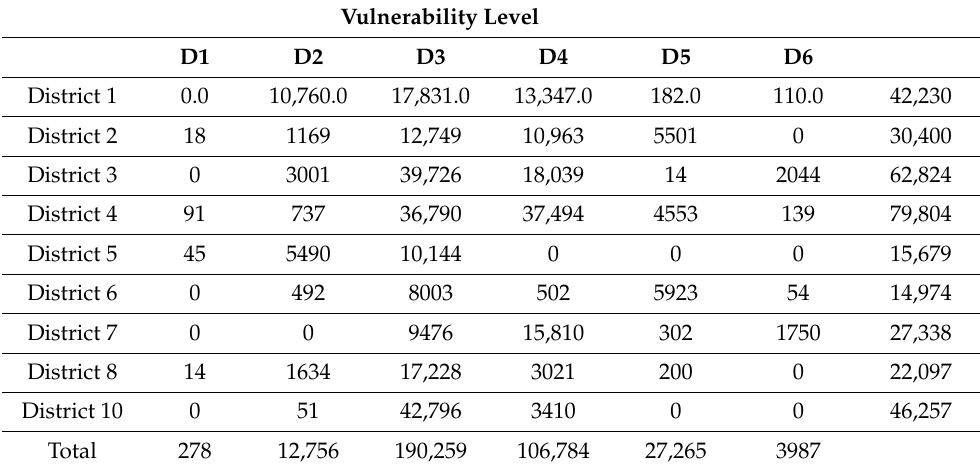
Table 8. Number of buildings damaged in terms of the level of destruction for the 1780 earthquake.